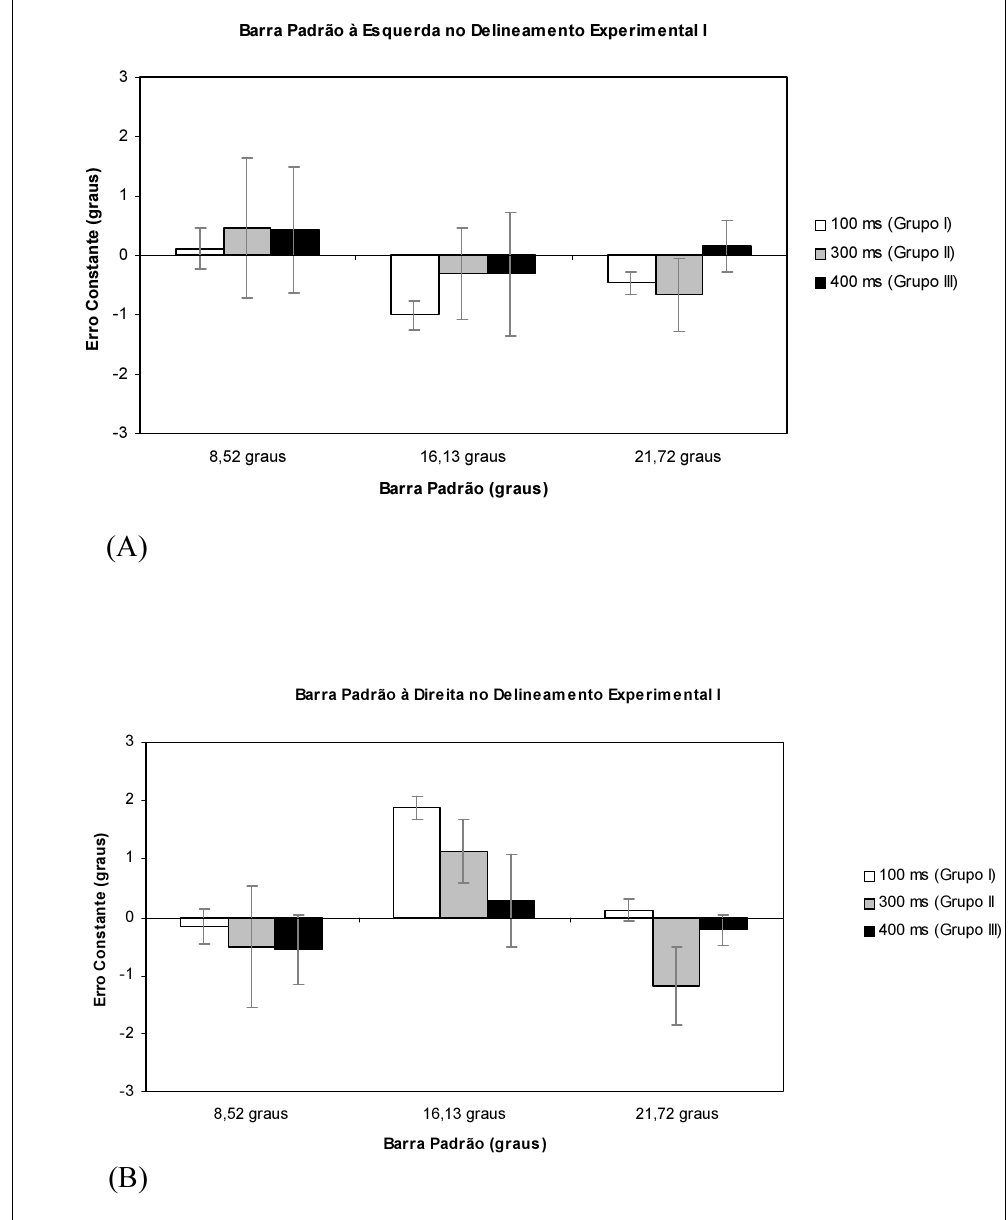
Figura 2 . Médias dos erros constantes dos três tamanhos da barra padrão, nos três tempos de exposição dos estímulos, com os respectivos erros padrão do Delineamento Experimental I Nota . (A) Condição em que a barra padrão foi apresentada à esquerda do ponto de fixação. (B) Condição